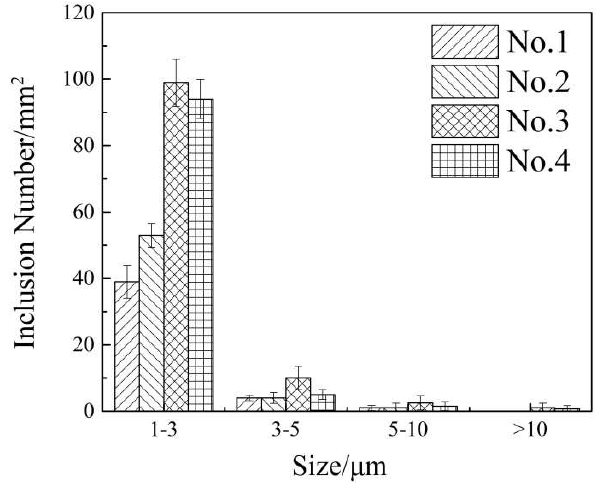
Figure 9. The number densities of inclusions in each billet.